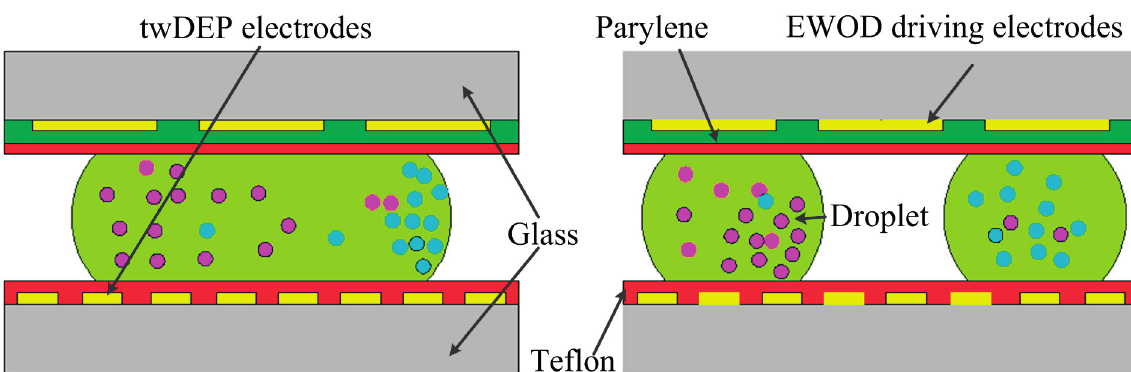
Figure 14. In-droplet particle separation procedures by twDEP and EWOD